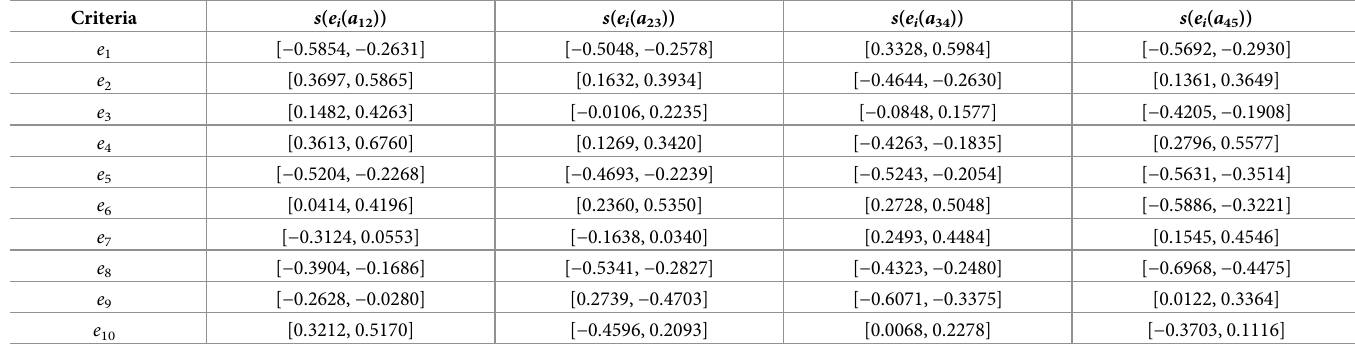
Table 1. Score intervals of the group IDPRs between neighboring candidates in the manager selection problem. Criteria